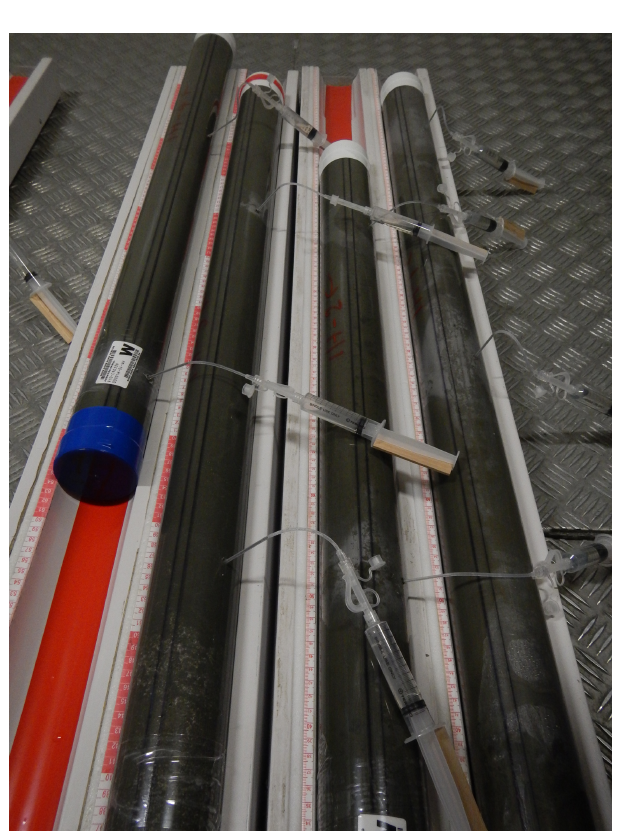
Figure 4. High-frequency pore water samples were taken from C9033B core sections using Rhizon samplers in a refrigerator room on the Chikyu